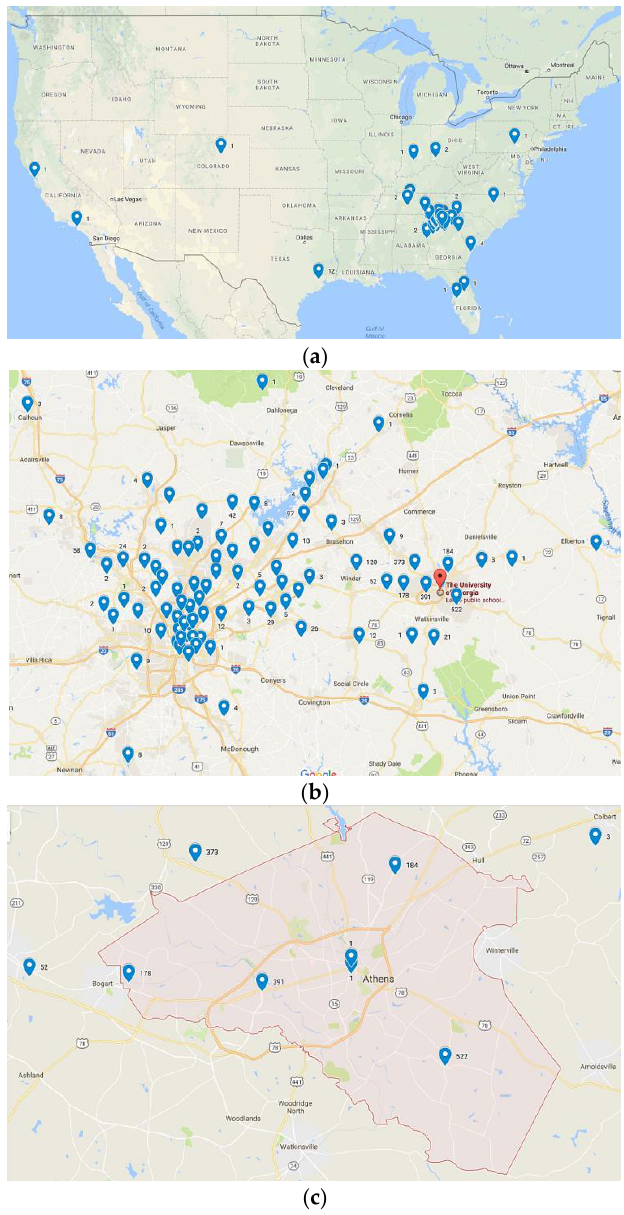
Figure 10. Zip codes associated with charging events. The number next to each marker indicates the frequency of that zip code: ( a ) Overall distribution including all valid zip codes. ( b ) Distribution of zip codes from the Athens and Greater Atlanta area. The red marker indicates the location of the University of Georgia. ( c ) Distribution of zip codes from Athens.